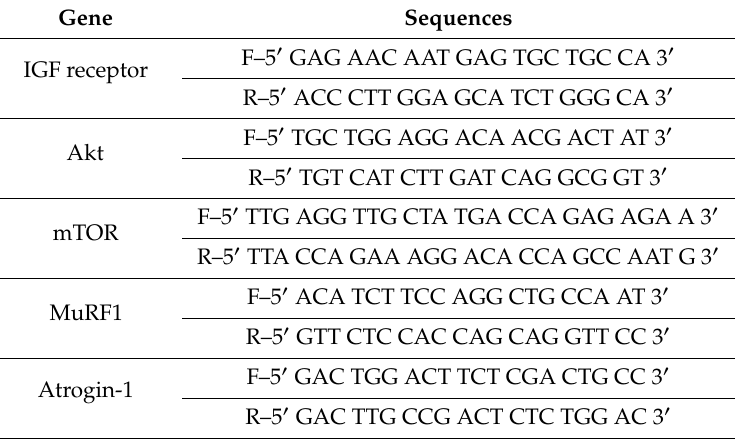
Table 1. Sequences of primers used for reverse transcription-polymerase chain reaction analysis. The primer sequences used to amplify the insulin-like growth factor 1 (IGF-1) receptor, protein kinase B (Akt), the mammalian target of rapamycin (mTOR), muscle RING-finger protein-1 (MuRF1), and muscle-specific F-box protein (atrogin-1) mRNA in muscles were confirmed by